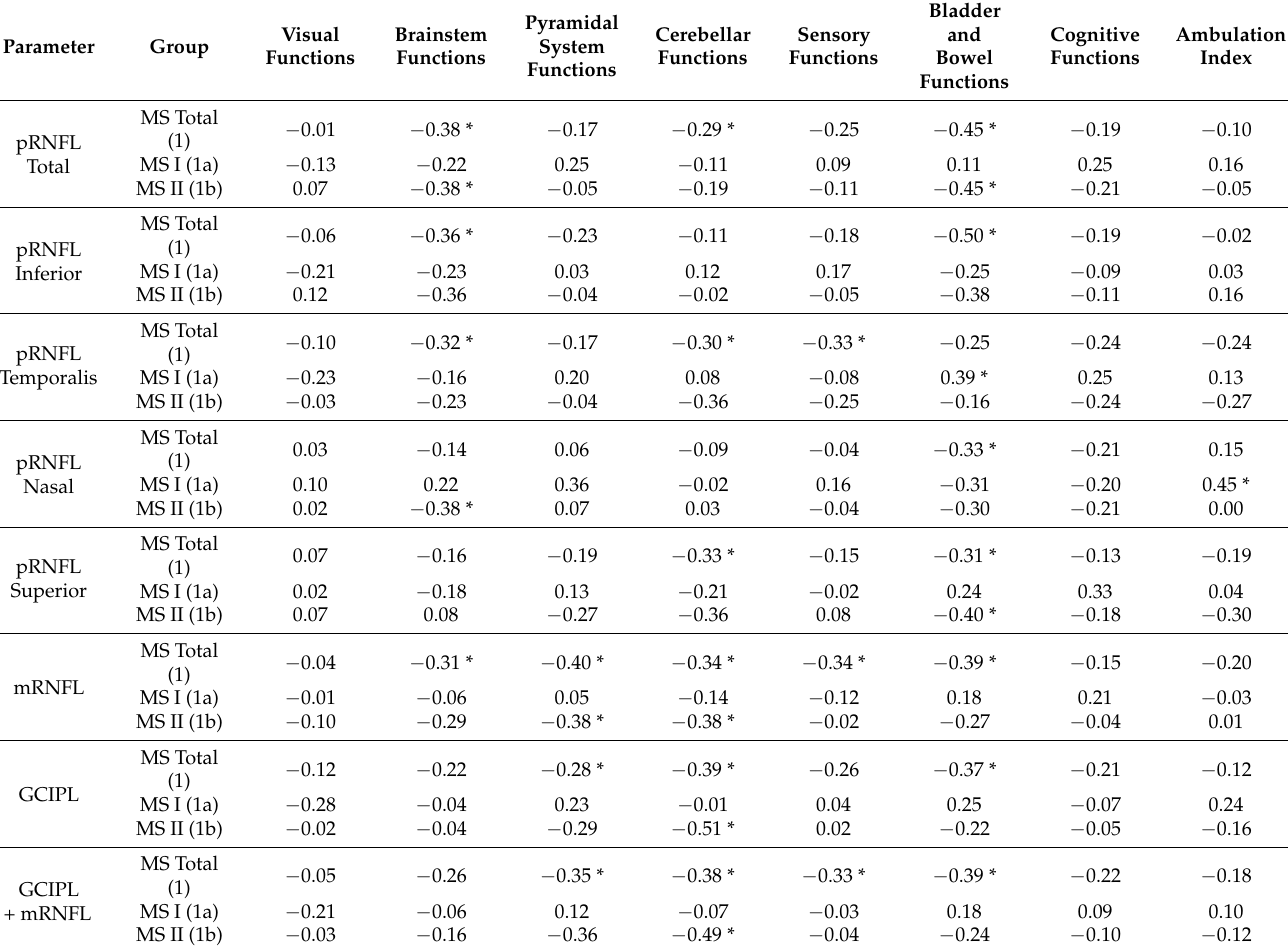
Table 9. Correlation between the OCT parameters and functional systems